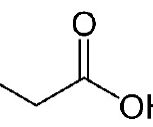
Figure 2. Gamma ‐ aminobutyric acid (GABA, 4 ‐ aminobutyric acid).